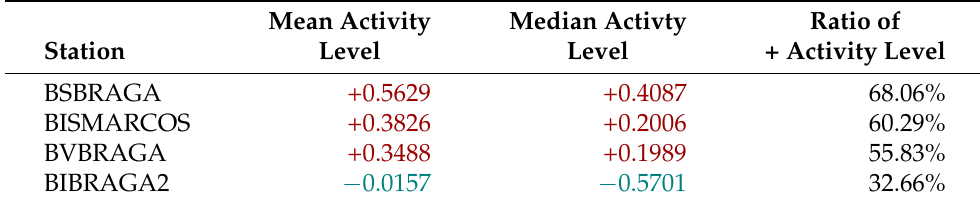
Table 5. Closer stations to emergencies with inefficient responses in Central Braga. Statistics from a sample of 695 potential inefficiencies. Red values indicate positive activity level and green values indicate negative activity